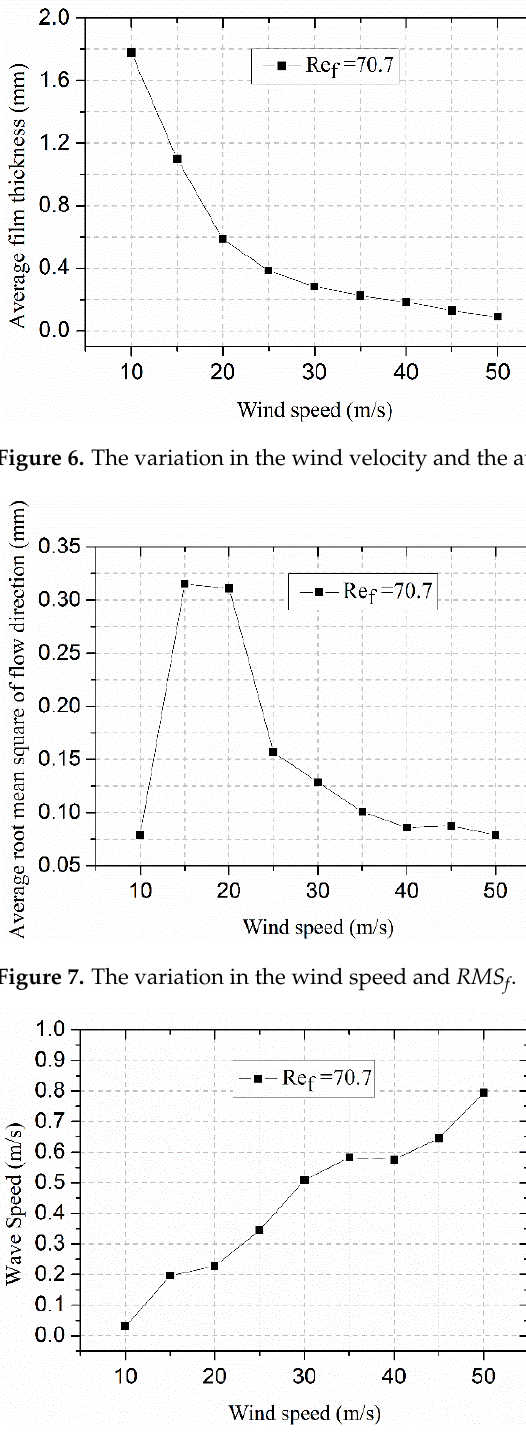
Figure 8. The variation in the wind and fluctuation velocity of the water film.